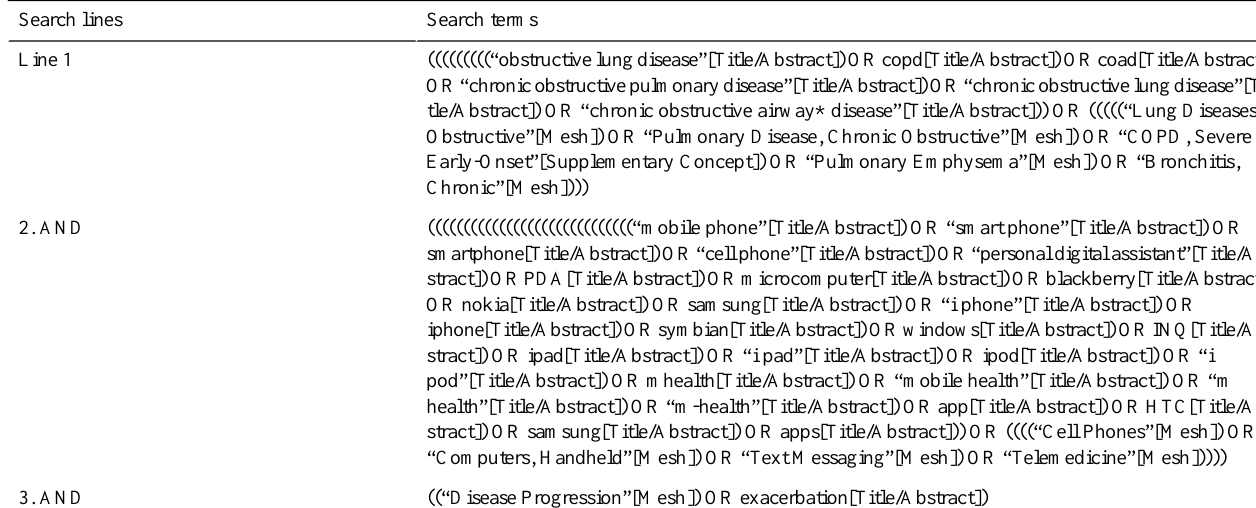
Table 1. Search terms for systematic